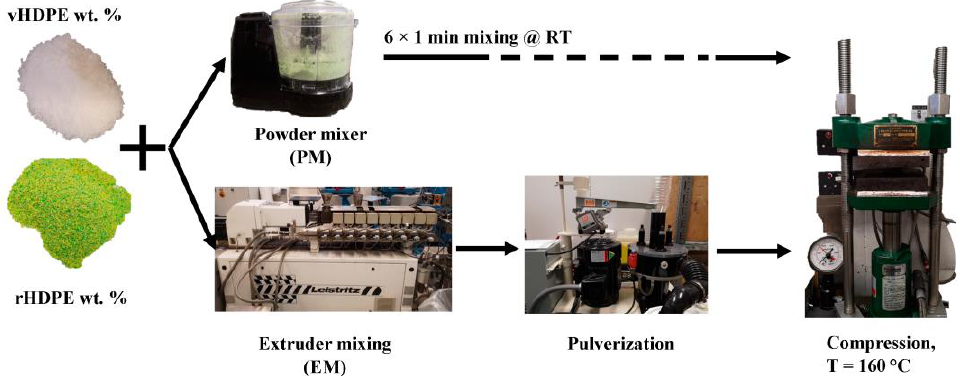
Figure 13. Schematic workflow of the specimen preparation by powder mixing (PM) and extrusion mixing (EM).